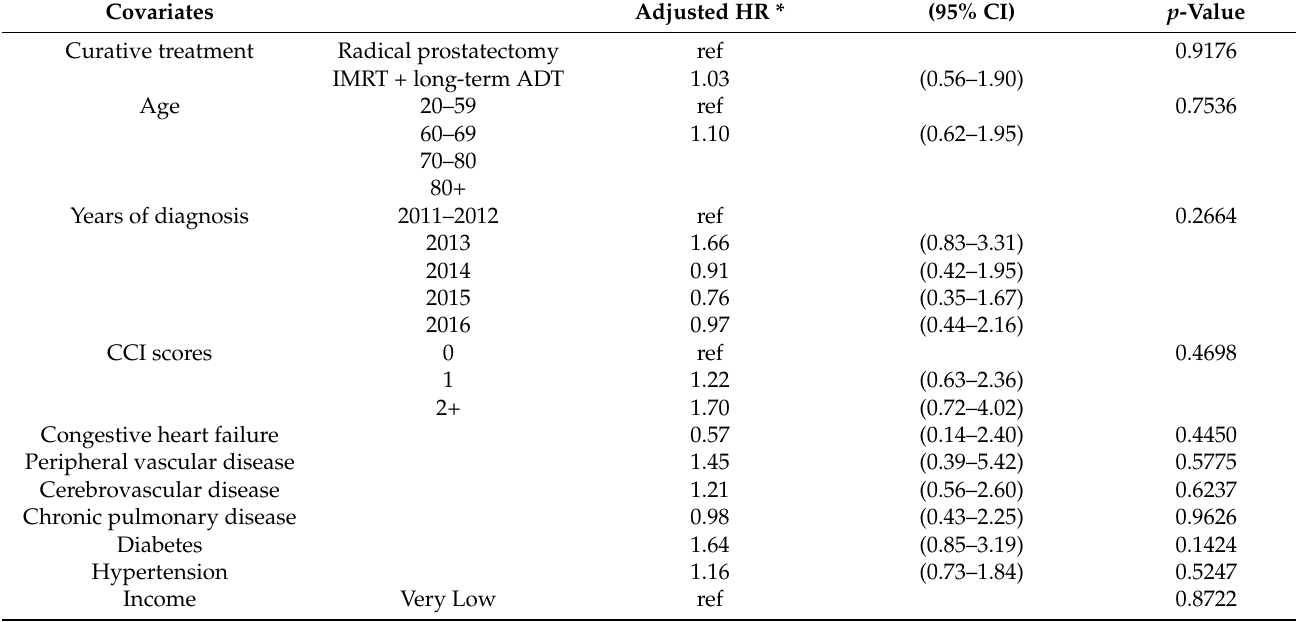
Table 5. Multivariate Cox proportional hazards regression analysis of distant metastasis in patients with high- to very high-risk of prostate